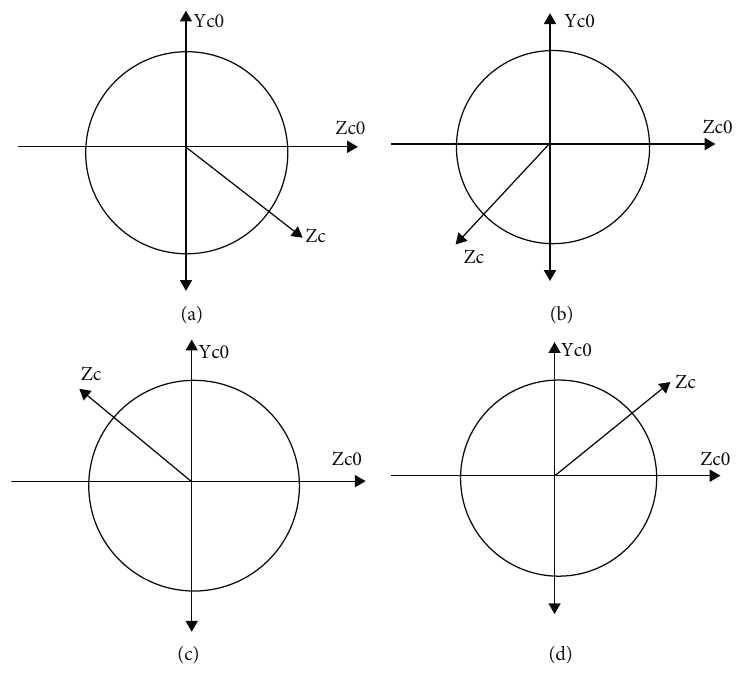
Figure 3: Diagram of rolling angle